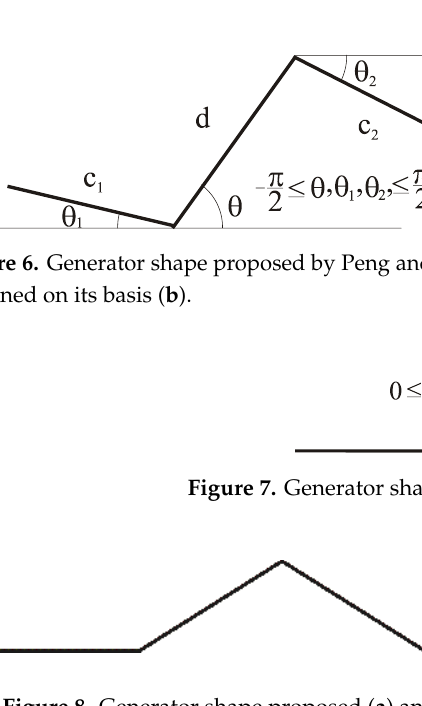
Figure 8. Generator shape proposed ( a ) and an example of fractal obtained on its basis ( b ).